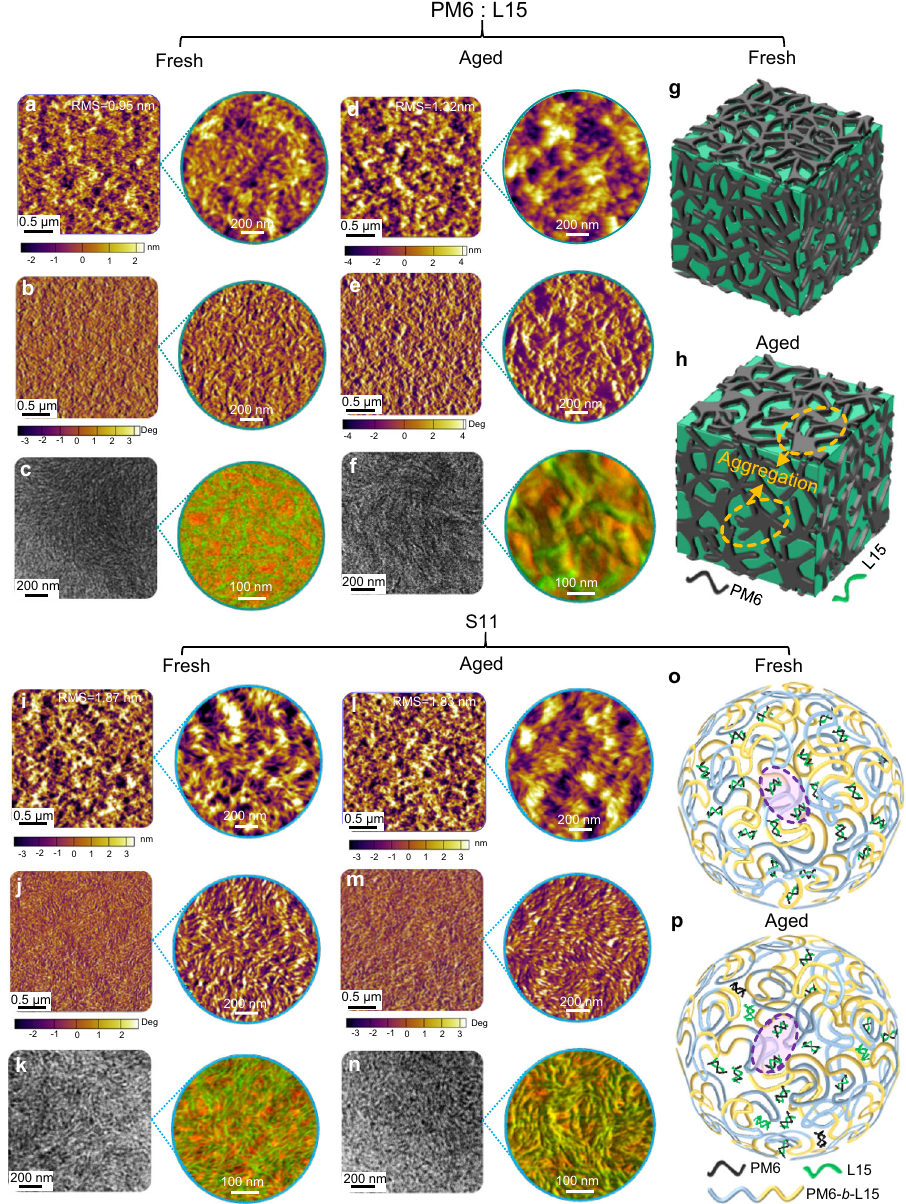
Fig.6|Morphologyevolutionduringtheagingtest. TheOSCsbasedonPM6:L15 and S11 active layers under continuous heating of 984h: a , d , i , l AFM height, b , e , j , m phase and c , f , k , n TEM and combined PiFM images for two-component system PM6:L15 and multicomponent system S11 fi lms before and after aging,